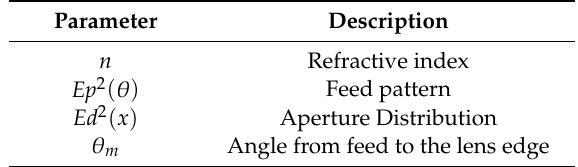
Figure 2. Lens configuration and parameters. Table 1. Antenna parameters.